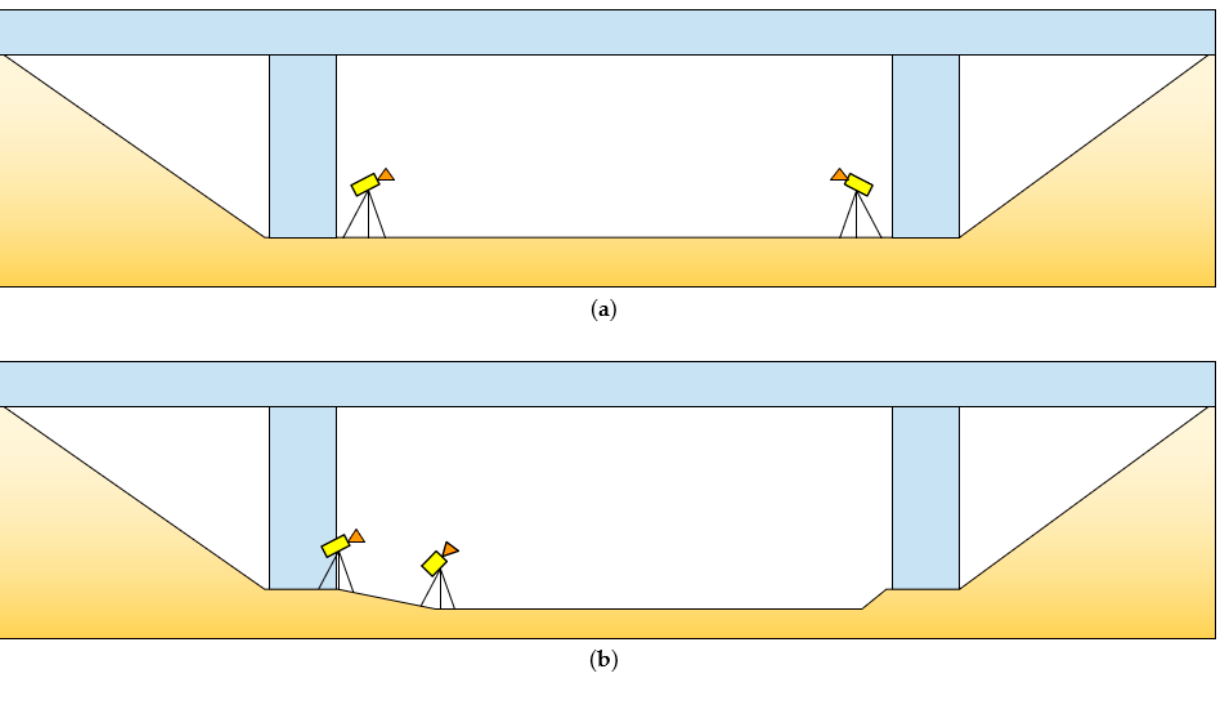
Figure 4. Relationship of displacement vector [𝑠 vertical angles 𝜓